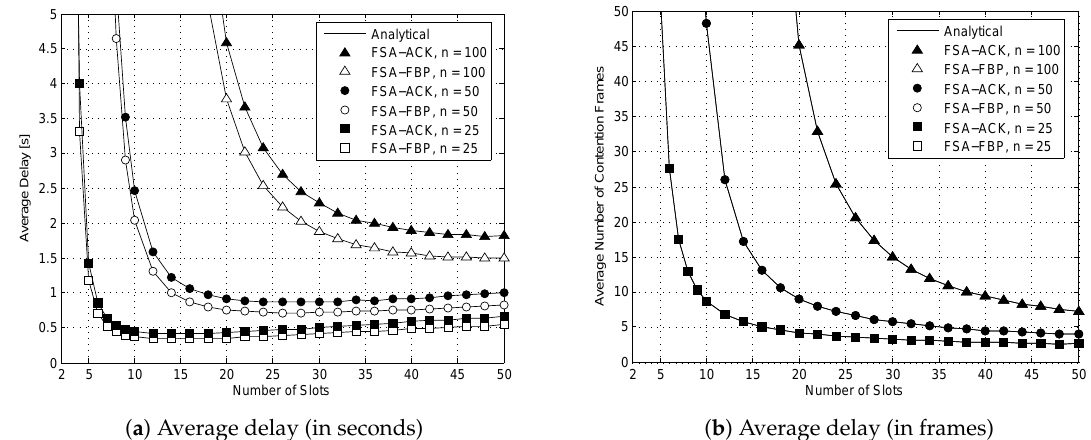
Figure 4. Coordinator and end-device average delay using FSA-ACK and FSA-FBP.